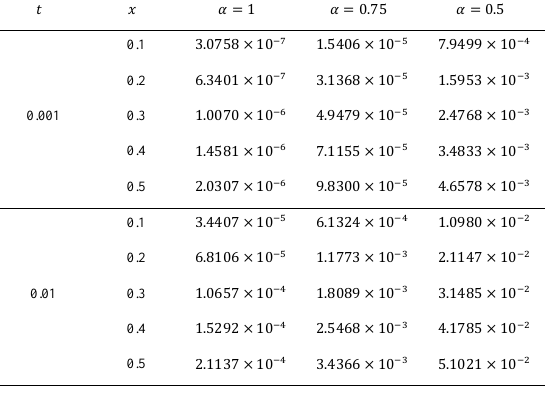
Figure 6. A plot of approximate solution 𝑢(𝑥, 𝑡) with respect to ℏ for Ex. 2 when (i) 𝑛 = 1 and (ii) 𝑛 = 2 when 𝑥 = 5,B 0 = 1, 𝜆 = 2,𝑎 = 1, and 𝑡 = 0.001 for distinct 𝛼 . Table 3. Numerical simulations for Ex. 2 at 𝑛 = 1, 𝛼 = 1,ℏ = −1, B 0 = 1,𝑎 = 1, 𝜆 = 2 for various values of 𝑥 and at 𝑡 = 0.001,𝑡 = 0.01